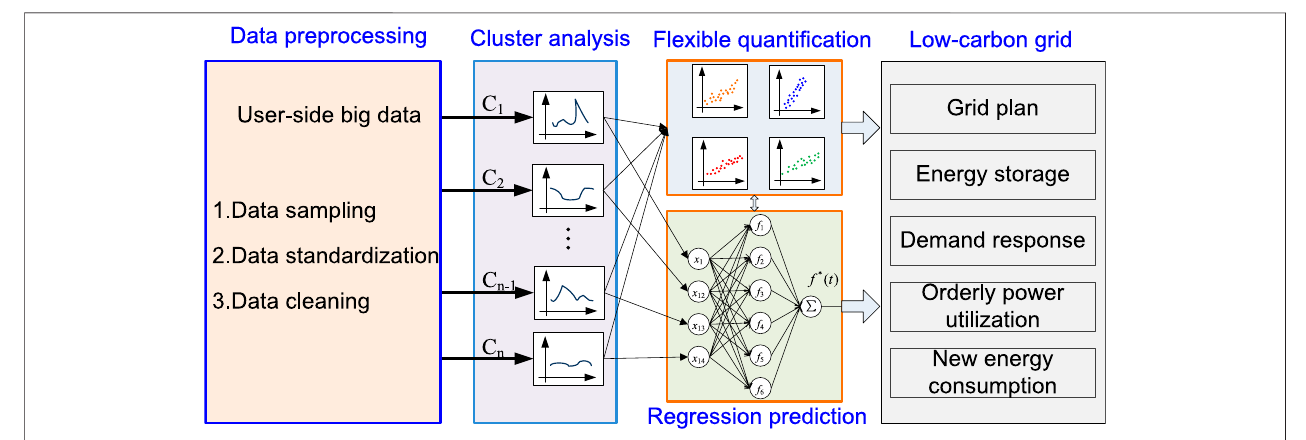
FIGURE 6 | Framework work of data intelligent analysis based on machine